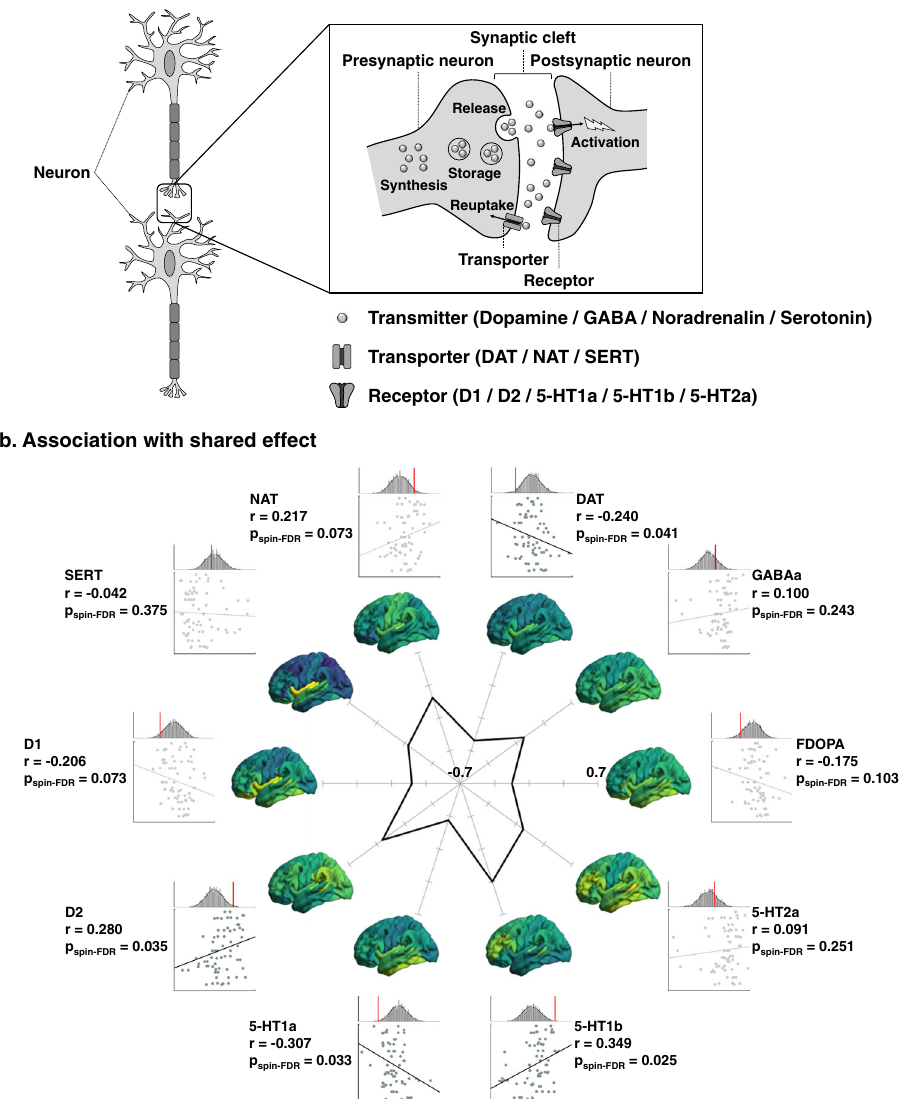
Fig. 3 Associations of neurotransmitter systems with shared disease effect. a Schema of neurotransmitter systems of transmitters, transporters, and receptors. b Spatial correlations of each neurotransmitter map with shared effect are shown on scatter plots. The distributions of correlation coef fi cients across 1000 spin-tests are reported with histograms, and actual r -values are reported with red bars. The spider plot shows correlation coef fi cients. Cortex- wide spatial maps of the transmitter systems are reported on brain surfaces. FDOPA 18 F fl uorodopa, DAT dopamine transporter, NAT noradrenaline transporter, SERT serotonin transporter, spin-FDR spin-test followed by false discovery